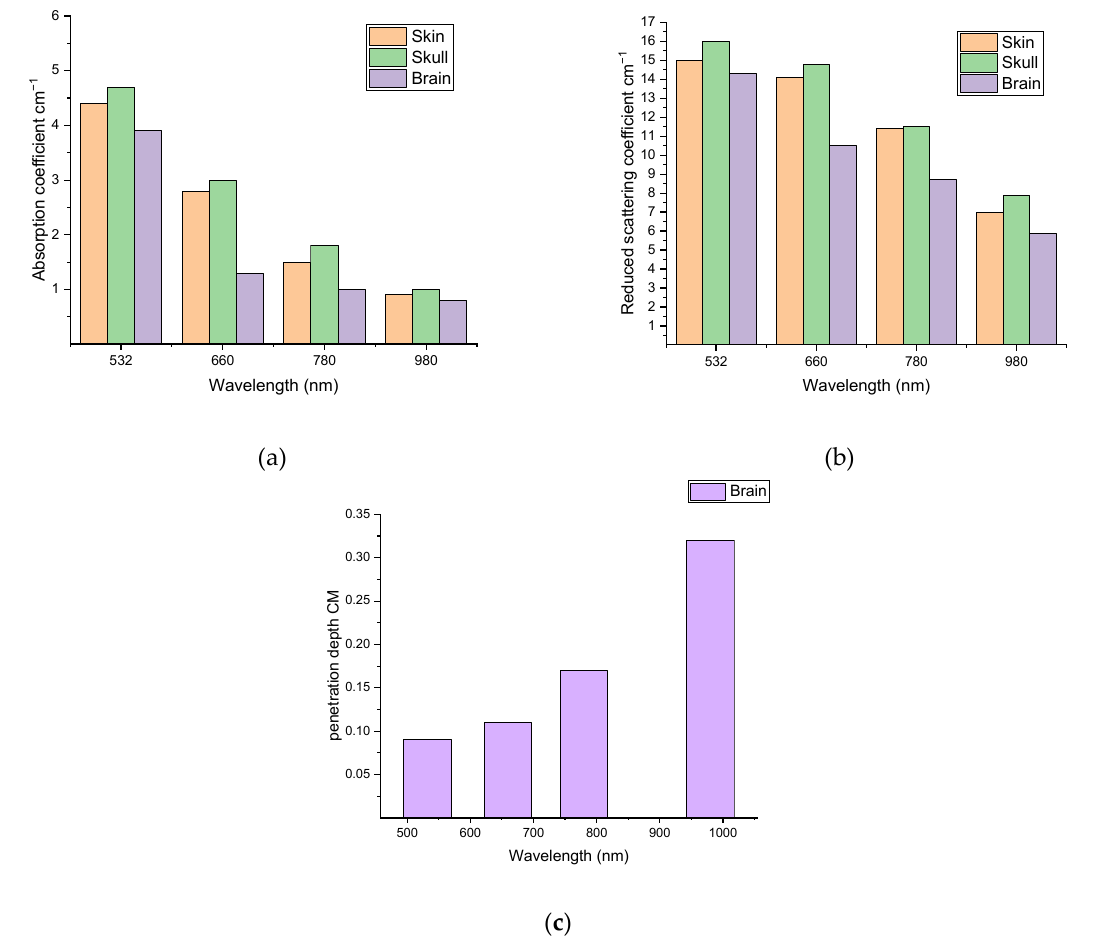
Figure 10. Variation in the calculated optical parameters at different wavelengths for all three investigated types of rabbit head tissues: absorption coefficient ( a ), reduced scattering coefficient ( b ), and penetration depth of the rabbit brain using Equation (10) ( c ).